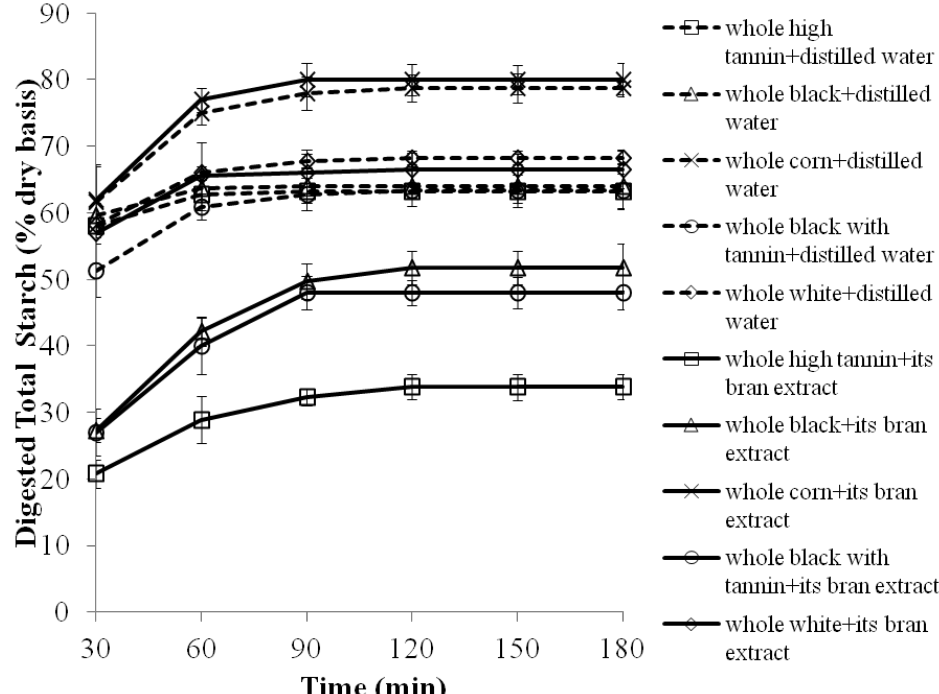
Figure 3. Starch digestibility of whole sorghum flour porridges made with sorghum bran extracts as a function of time (porridges used the equivalent of 50 mg of starch on a dry weight basis). Values are means ± standard error of n = 3 samples per treatment. Dash lines are controls, which are whole grain flours cooked with distilled